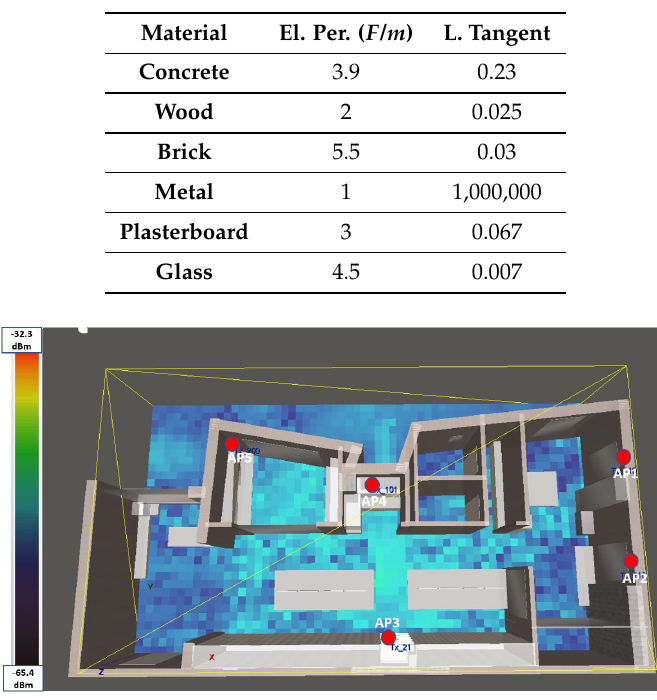
Table 2. Material constitutive parameters of the test environment.